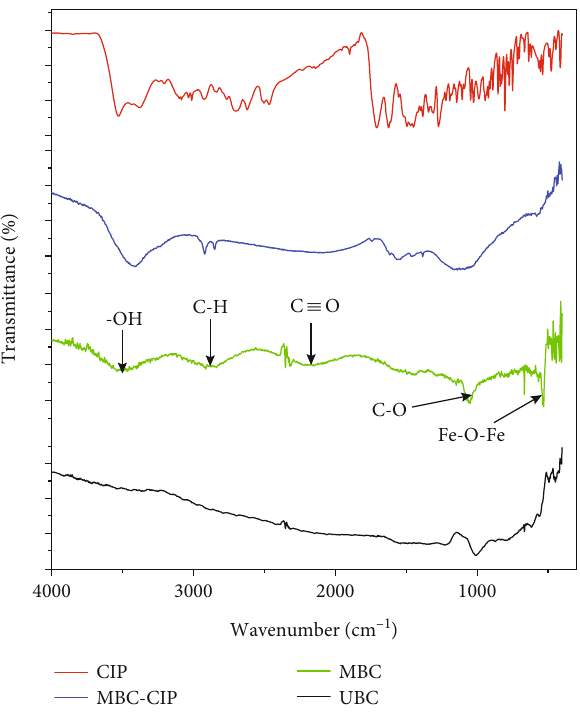
Figure 1: FTIR spectra of unmodi fi ed (UBC), modi fi ed biochar (MBC), modi fi ed biochar after adsorption (MBC-CIP), and cipro fl oxacin